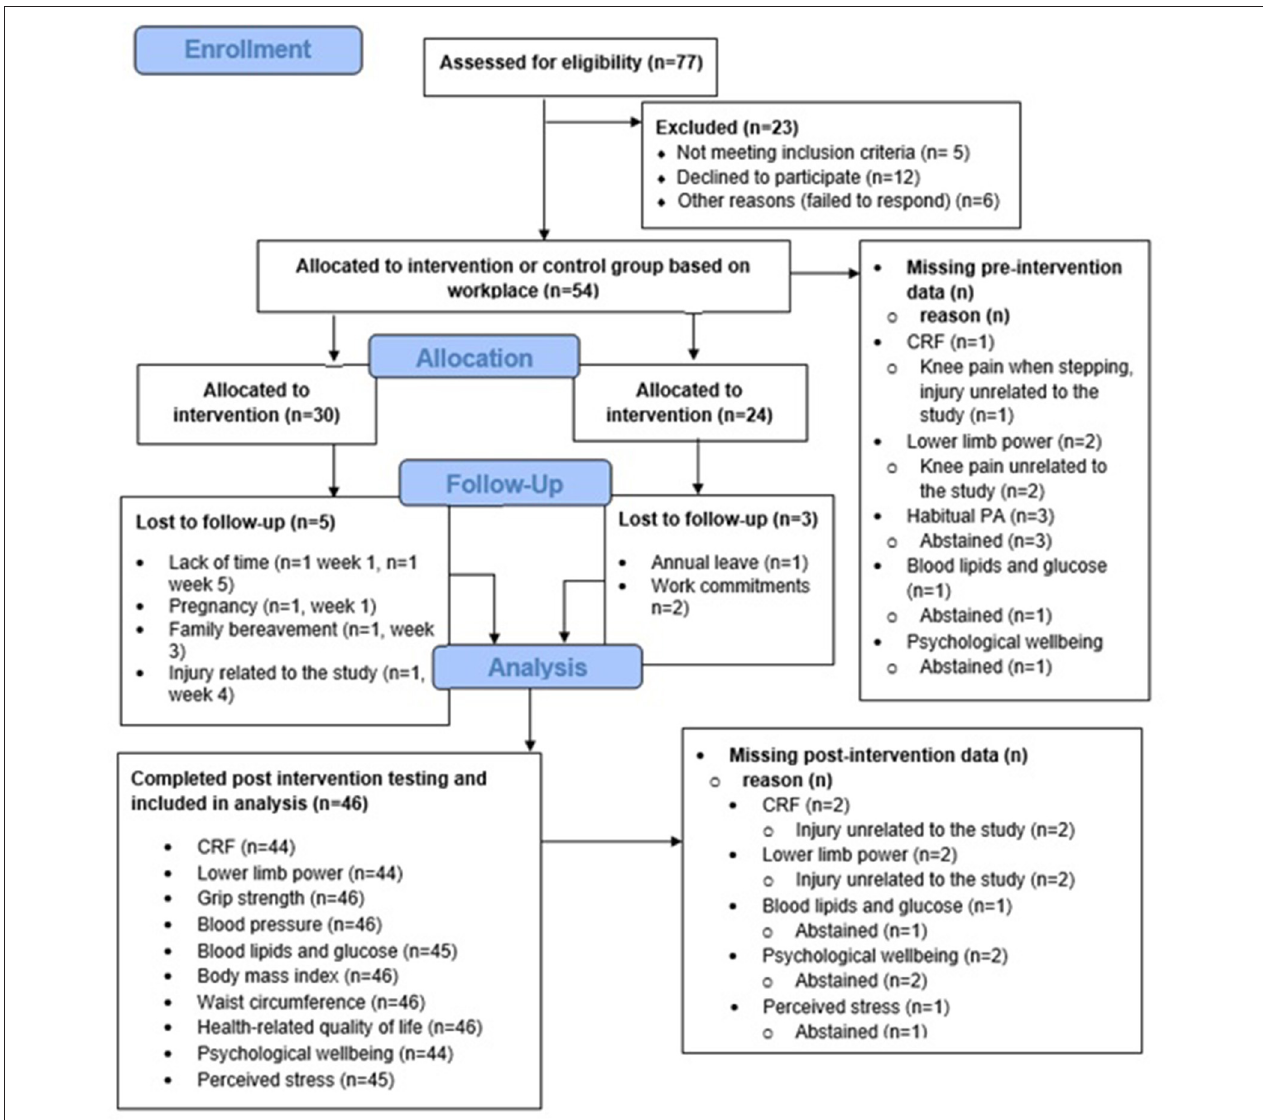
FIGURE 1 | CONSORT 2010 flow diagram (Eldridge et al.,